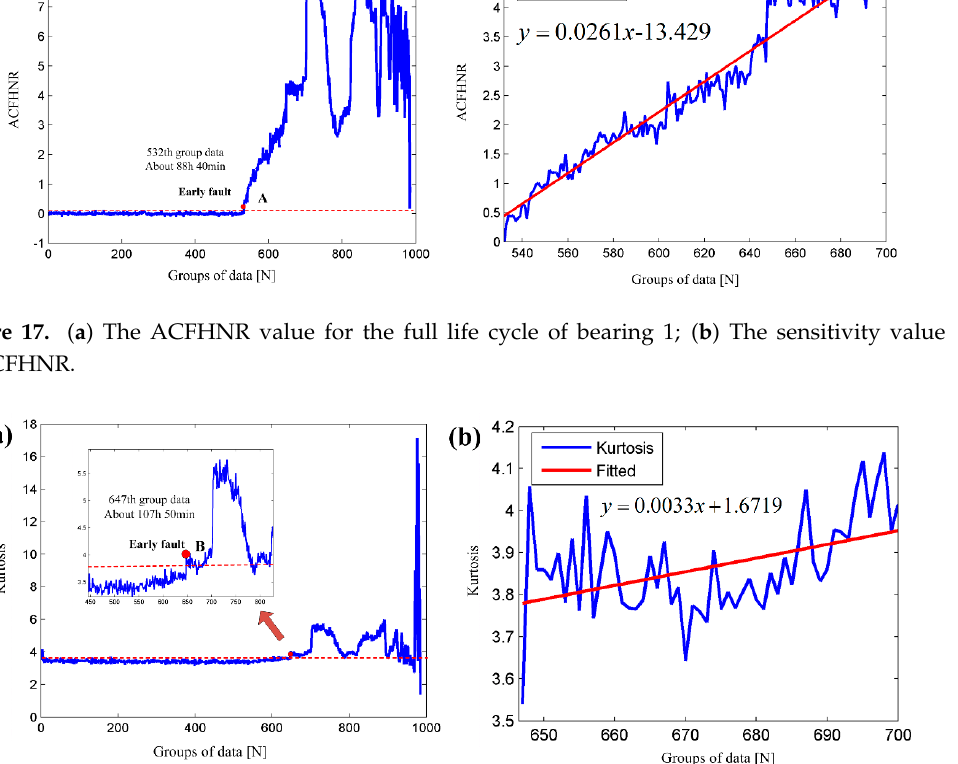
Figure 19. ( a ) The RMS value for the full life cycle of bearing 1; ( b ) The sensitivity value of RMS.